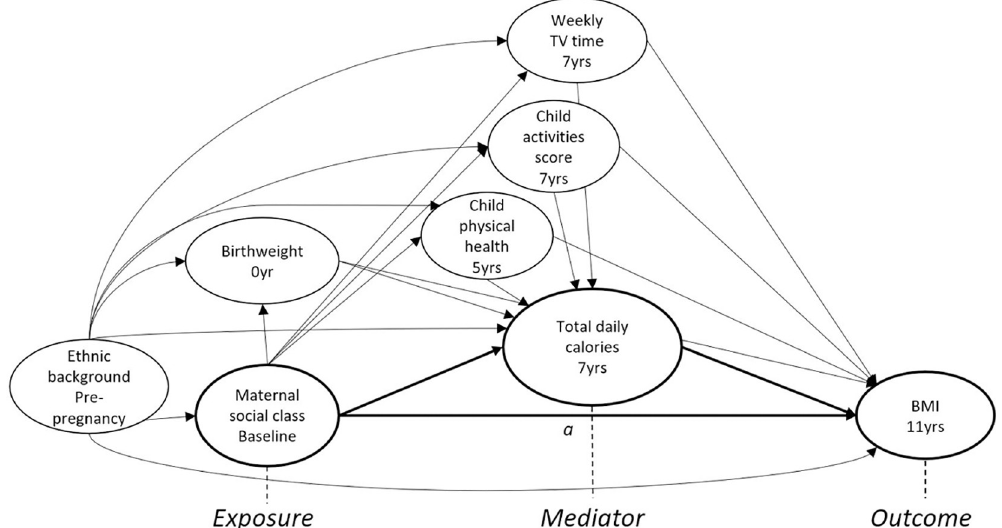
Fig 1. Directed acyclic graph showing theoretical associations between exposure (maternal social class at 0 years), mediator (total daily calories at 7 years) and outcome (BMI at 11 years). a The controlled direct effect was provided after adjusting total daily calories (accounting for baseline and intermediate confounding) and estimating the effect of maternal social class on obesity. Intervention scenarios were modelled by simulating reductions to calorie intake (varying in effectiveness, targeting and uptake) with impacts on population prevalence and inequalities in obesity